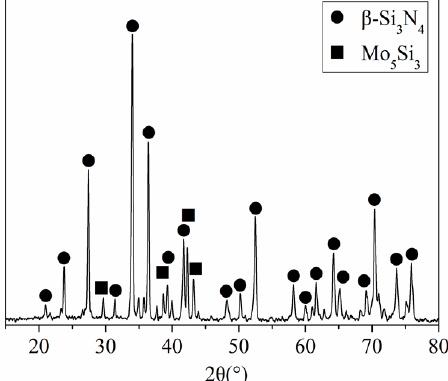
Figure 4. The XRD result of 9SM composites.